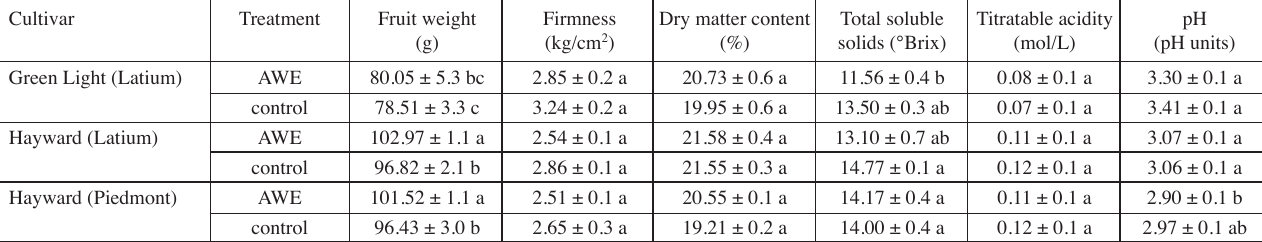
Tab. 2: Quality parameters in cv. Green Light and cv. Hayward: mean values in each row for the same parameter followed by different letters are significantly different as determined by Tukey’s HSD test following ANOVA ( p ≤ 0.05). Cultivar